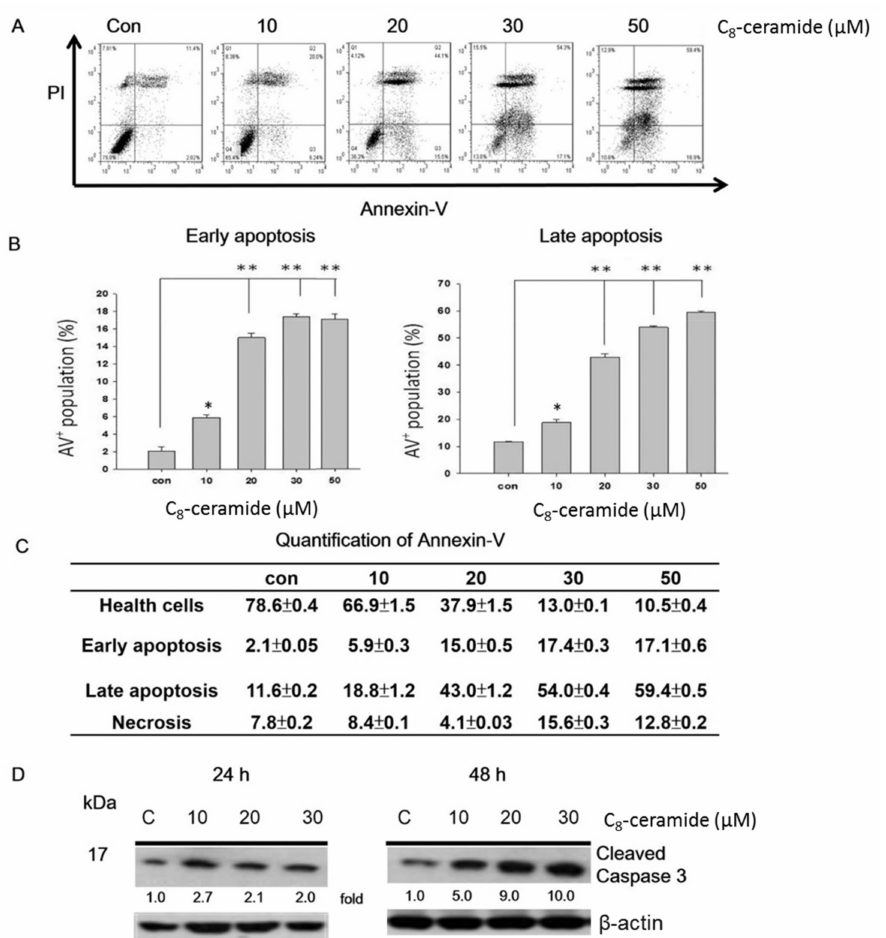
Figure 3. C 8 -ceramide-induced apoptotic profiles of lung cancer H1299 cells. Cells were treated with indicated concentrations (from 10 to 50 µ M) C 8 -ceramide for 24 h and 48 h respectively. ( A ) Representative profiles of apoptosis detected by Annexin V/PI double staining in C 8 -ceramide-treated H1299 cells for 48 h. ( B ) Population assessment of early and late-stage apoptosis. * p < 0.05, ** p < 0.001 for C 8 -ceramide treatment versus respective control. ( C ) The results of the quantitative analysis for apoptosis population (%). Data, mean ± SD ( n = 3). ( D ) The proteolytic activation (cleaved form) of caspase-3 in C 8 -ceramide treated H1299 cells. β -actin as an internal